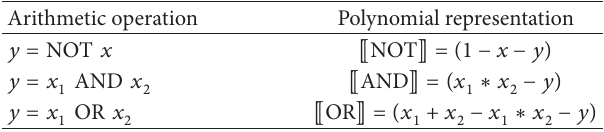
Table 2: Polynomial model for logic operation. Arithmetic